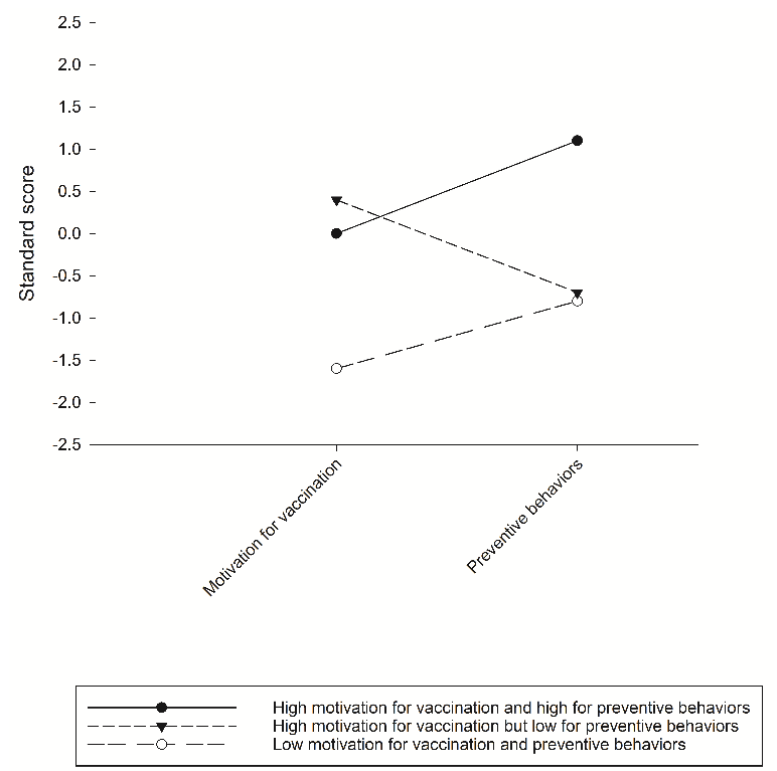
Figure 1. Three classes of participants with various levels of motivation to receive COVID-19 vac- cination and to adopt preventive behaviors.